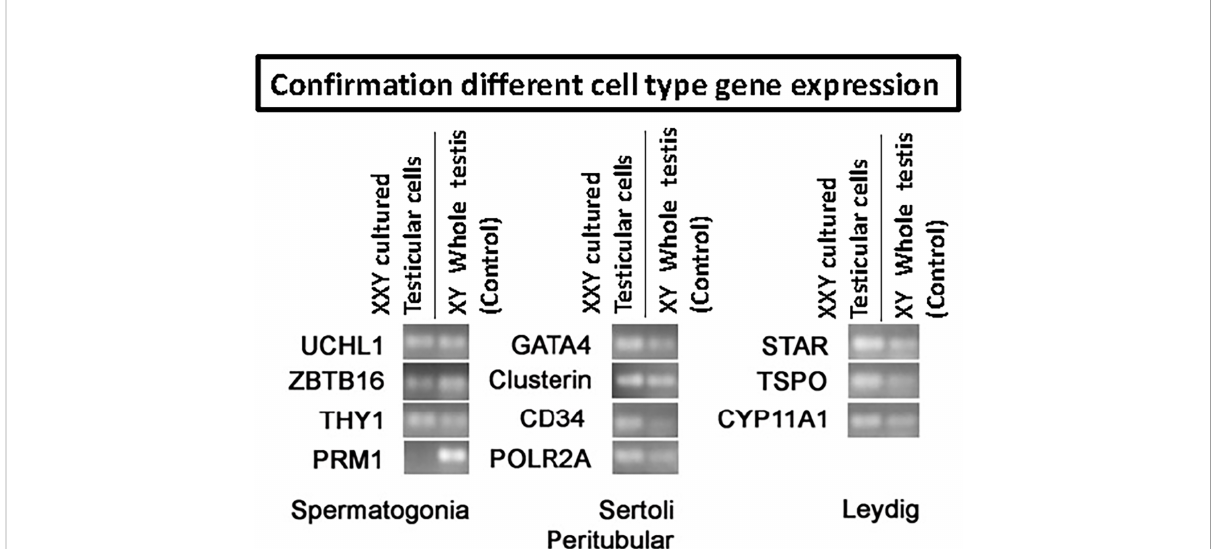
FIGURE 4 RT-PCR to con fi rm the presence of the four main testicular cells in culture based on cell-speci fi c gene expression: spermatogonia (UCHL1, ZBTB16, THY1, PRM1), Sertoli (Gata4, Clusterin), peritubular (CD34) and Leydig (STAR, TSPO, CYP11A1). POLR2A was used as a housekeeping gene for internal control. Results con fi rmed the presence of all four common cell types. However, differentiated germ cell marker PRM1 remained negative, indicating the undifferentiated status of the germ cells in culture.